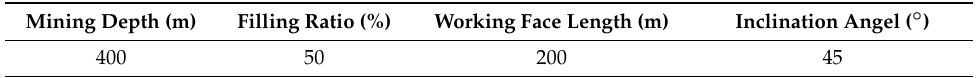
Table 1. Basic conditions for influencing